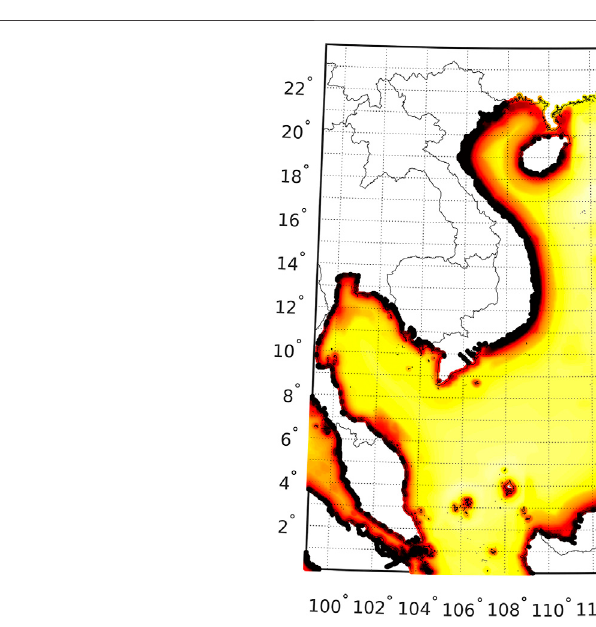
FIGURE A1 | Associated errors of EGM2008 in terms of quasi-geoid heights.